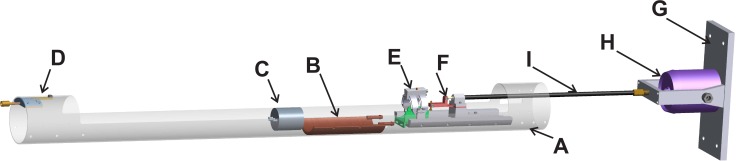
Overview of the MR compatible indentation and MRE setup.Following parts are labeled: Fiberglass tube (A), 3D-printed heating blanket (B), anesthesia mask (C), fixation block (D), indentor (E), MRE actuator (F), shaker base plate (G), electromagnetic shaker (H). Part E and F are shown in more detail in Fig 2.